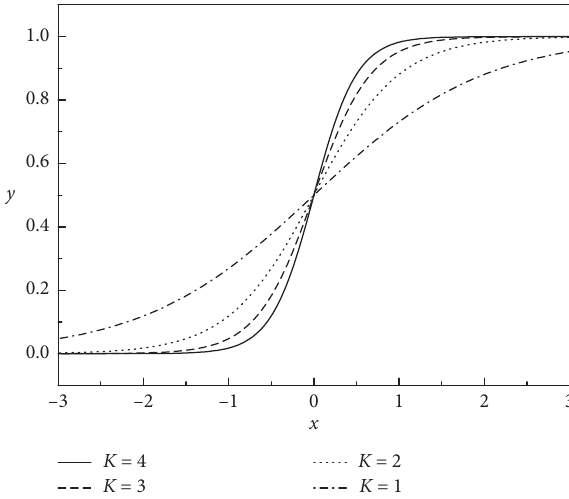
Figure 10: Diagram comparison of different K value functions.